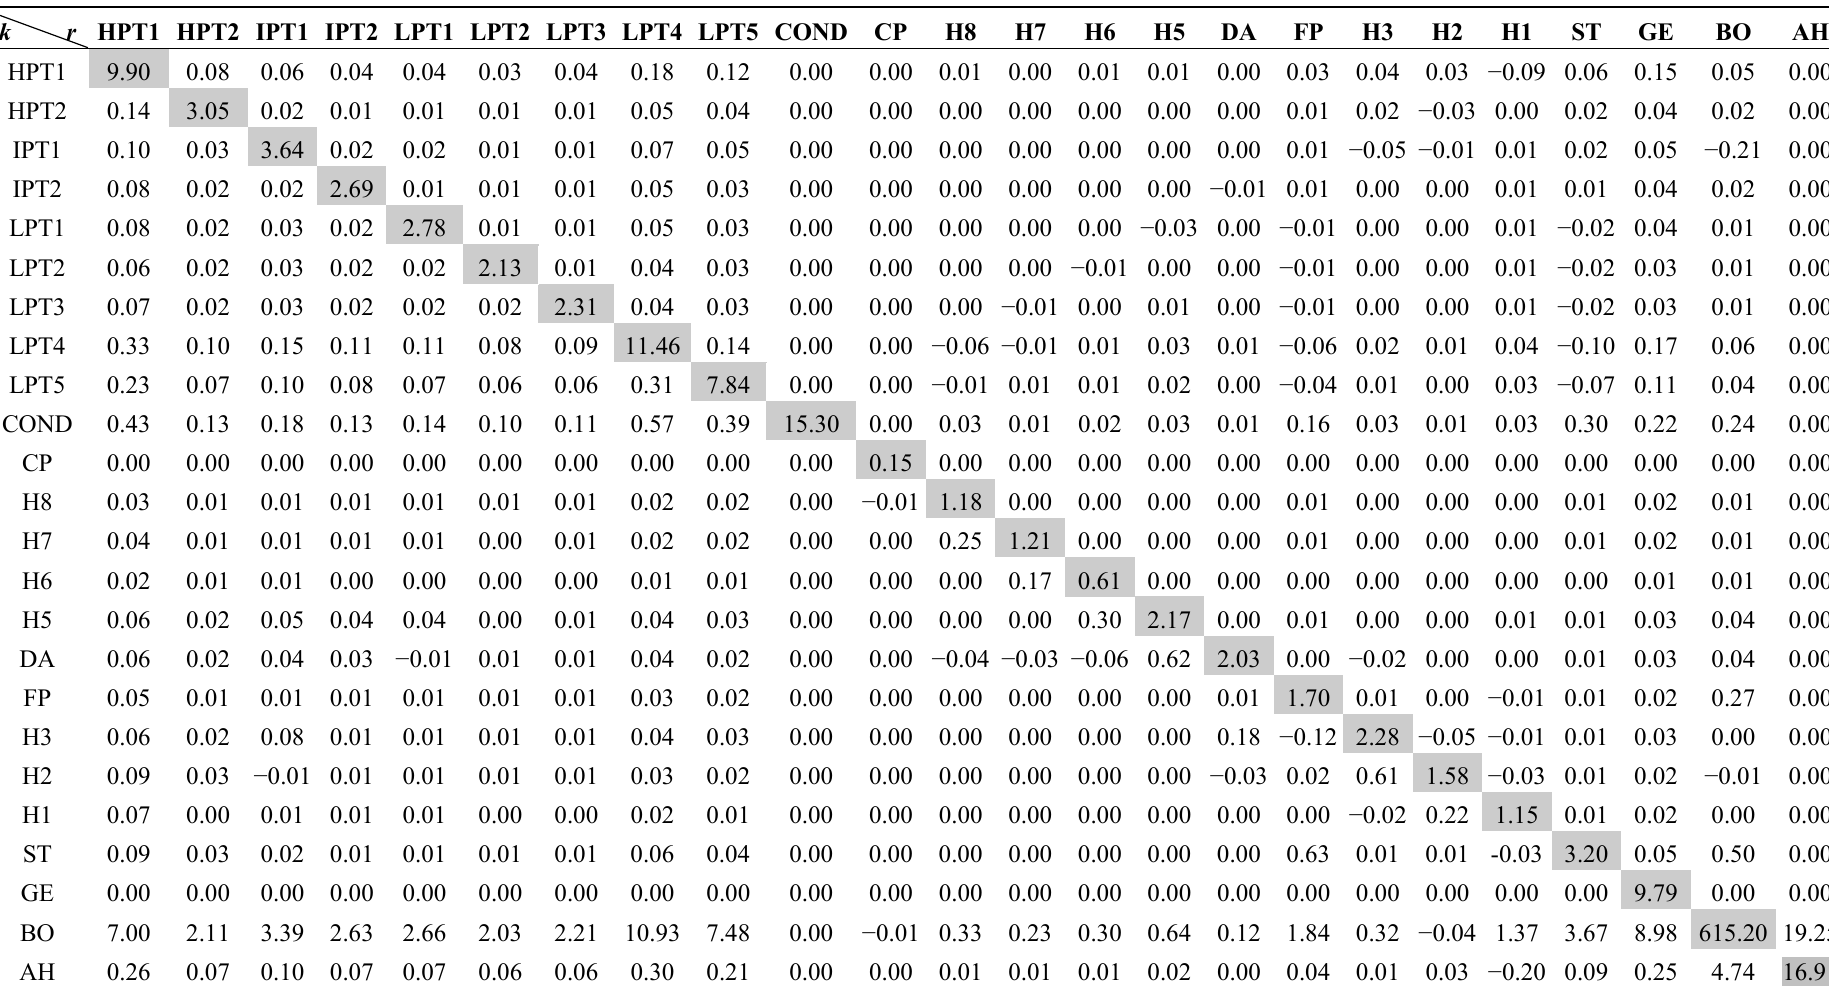
Table 6. Endogenous exergy of component k and the exogenous part caused by component r